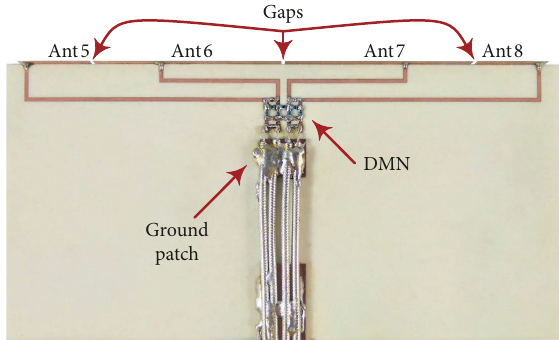
Figure 5: Top view of the manufactured prototype.